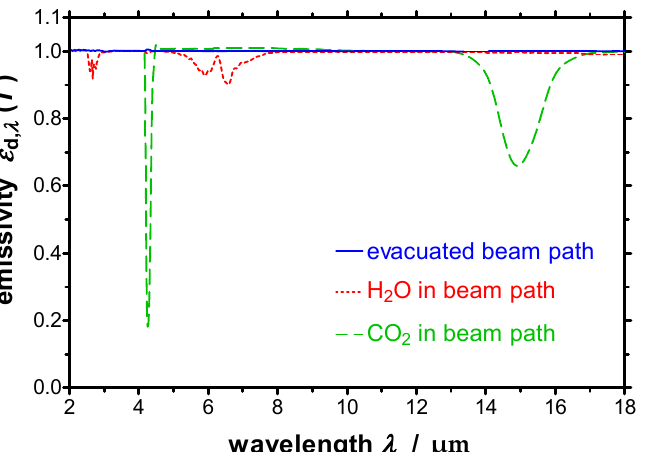
Figure 6. Three measurements of the spectral directional emissivity were realized with a reference blackbody at T = 873 K. For the first measurement the beam path was evacuated, then either the H 2 O or the CO 2 content in the beam path was consecutively increased.